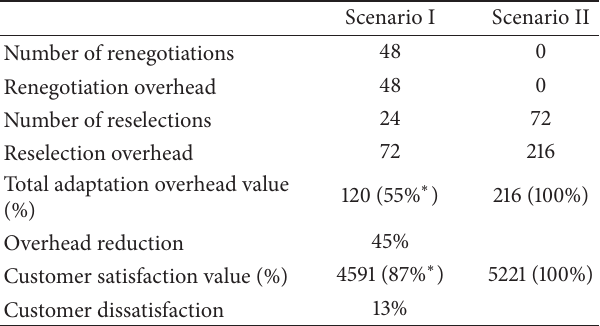
Table 2: Adaptation efficiency